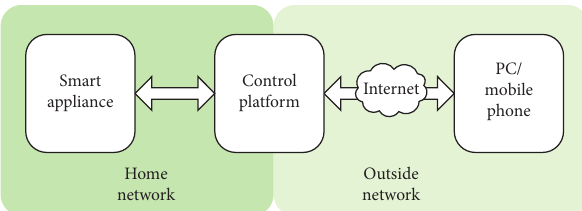
Figure 2: Smart home control